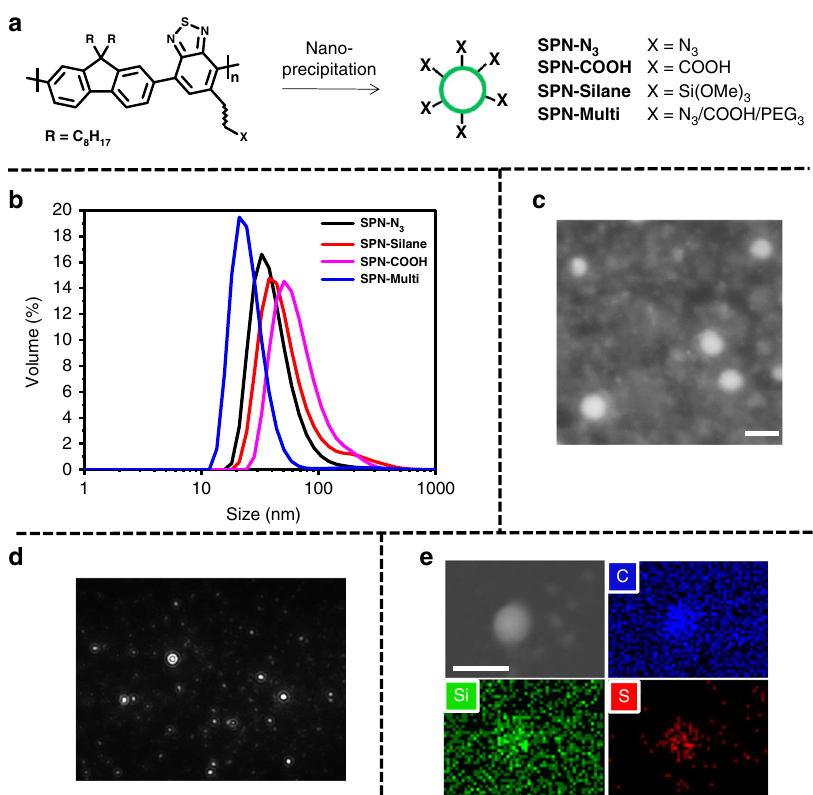
Fig. 4 SPN synthesis and characterisation. a Schematic of the preparation of SPNs from functionalised polymers. b Size distribution for SPN-N 3 , SPN- Silane , SPN-COOH and SPN-Multi , determined by dynamic light scattering (DLS), averaged over three measurements. c Scanning transmission electron microscopy (STEM) image of SPN-N 3 nanoparticles. Scale bar 200 nm. d Image of SPN-N 3 nanoparticle suspension from nanoparticle tracking analysis (NTA). e STEM image of SPN-Silane nanoparticles, with EDX maps of carbon, silicon and sulphur content. Scale bars, 200